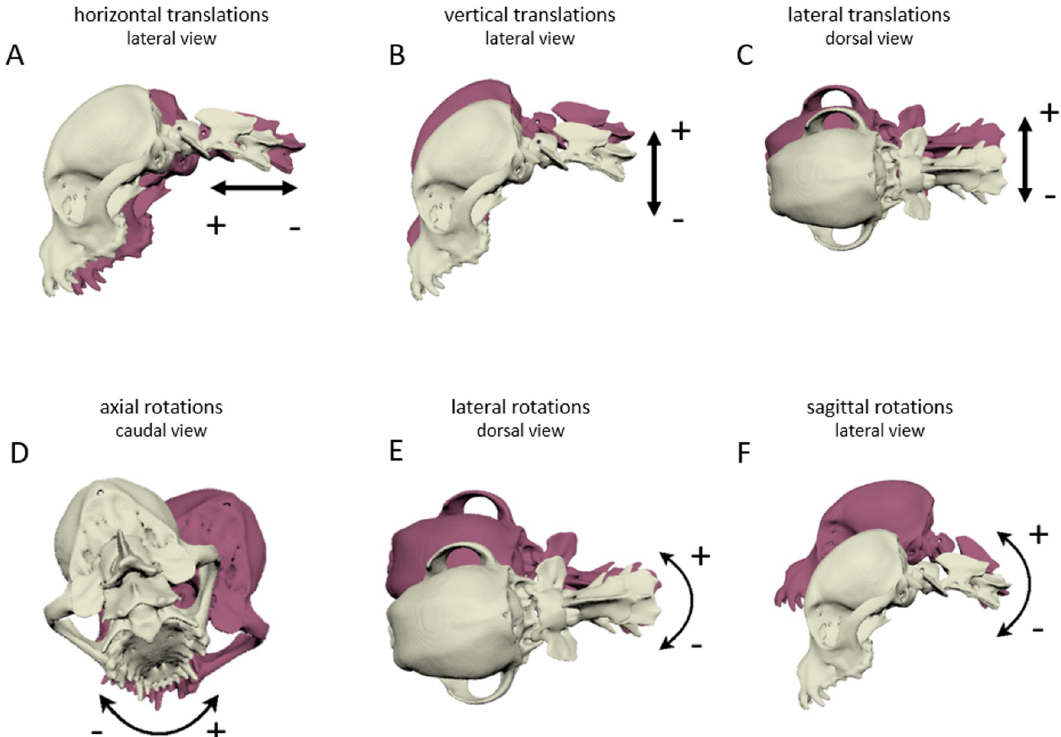
Fig 3. Translational and rotational movements in the bone models. Degrees of freedom during locomotion and arbitrary movements, demonstrated by XROMM images of the total cranial cervical spine. + indicates increasing values of the curves, − indicates decreasing values of the curves in Figs 5–7 in the direction of the arrows. A) horizontal translations along x-axis, lateral perspective, B) vertical translations along y-axis, lateral perspective, C) lateral translations along z-axis, dorsal perspective, D) axial rotations around x-axis, caudal perspective, E) lateral rotations around y-axis, dorsal perspective, F) sagittal rotations along z-axis, lateral perspective.